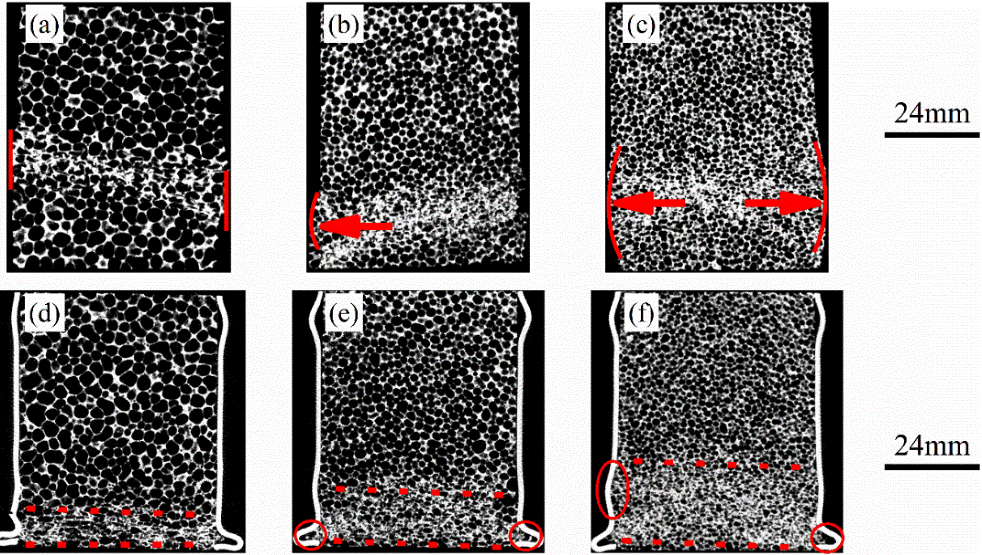
Figure 8. The deformation cross-sections of compressed foams and foam-filled tubes before the second fold is completed (20% displacement) Test No. 1 ( a ), Test No. 5 ( b ), Test No. 12 ( c ), Test No. 1, filled tube ( d ), Test No. 5, filled tube ( e ), Test No. 12, filled tube ( f ).